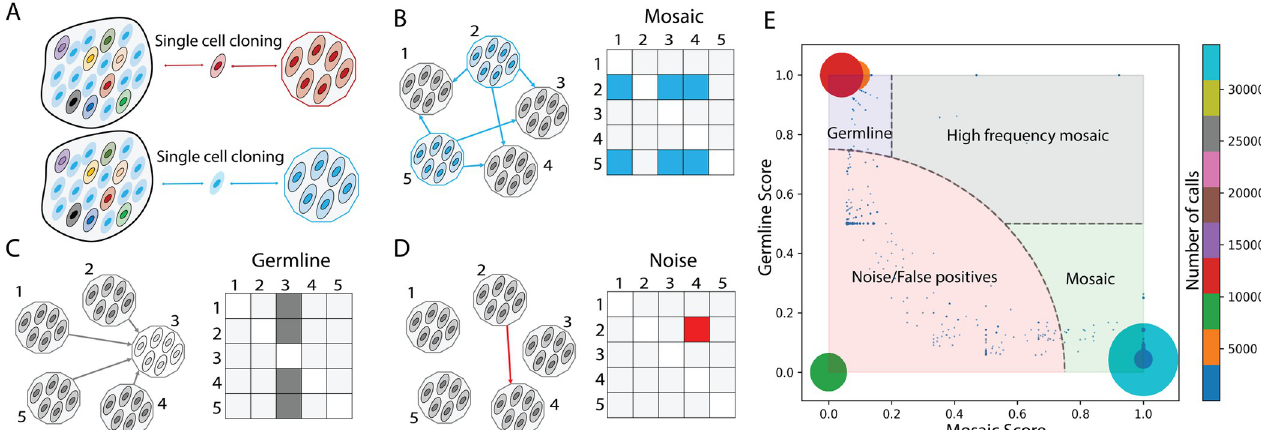
Fig 1. Conceptual overview of All 2 approach and scoring. (A) A tissue/sample is made up of different cells (ovals) carrying various mosaic mutations (reflected by different colors). Post single cell clonal expansion, rare mosaic mutations (in red) can be easily detected by comparing the clone to the bulk tissue. However, frequent mutations (in blue) will be missed by this approach. (B-D) Each mutation in clone-to-clone (which is cell-to-cell) comparison can be represented by a NxN matrix of pairwise clone comparisons, where each box represents the call between a clone in the row versus a clone in the column. ( B) In case of a true mosaic mutation, the calls are arranged as rows in the matrix. The pattern in the matrix shows that the mutation is called in clone 2 and clone 5 when comparing them to other clones. (C) In case of a germline variant, the calls are arranged in a column(s) in the matrix. The displayed pattern suggests that the mutation is present in all clones except clone 3. (D) The pattern has a sporadic distribution of calls in the pairwise matrix and does not suggest either mosaic mutations or germline variants. Such call is deemed as a false positive or noise. (E) Distribution of mosaic and germline scores for calls (the size of the dot/circle corresponds to the number of calls with the same scores; the color represents number of calls depicted in the colorbar. The plot can be divided into four areas: mosaic mutations (light green area, where the mutations have high mosaic scores and low germline scores), germline variants (light blue area, where the mutations have high germline and low mosiac scores), high frequency mosaic mutations (light gray area, where calls have both high mosaic and high germline scores) and, lastly, noise or false positive calls (light red area).